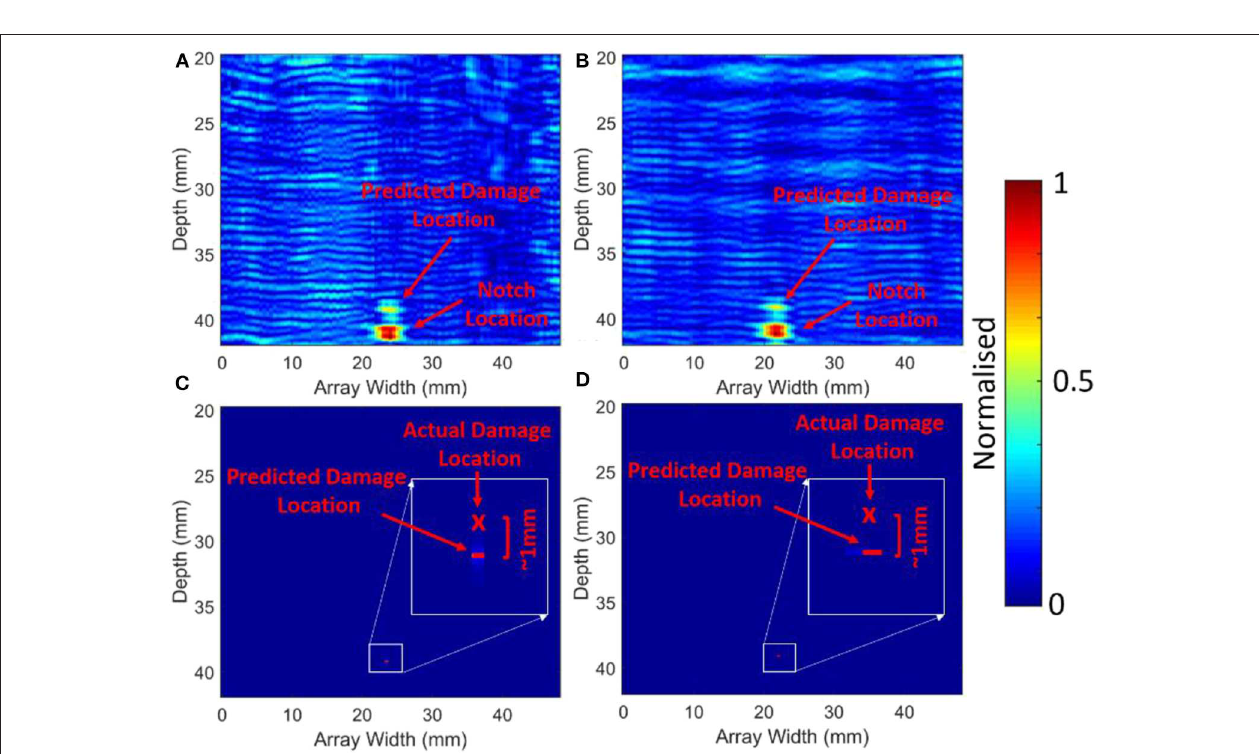
FIGURE 10 | SFC sample comparison of dual frequency (f 1 & f 2 = 4.8 & 5.3 MHz) and tri frequency modulation (f 1 & f 2 & f 3 = 4.8 & 5 & 5.2 MHz): (A) dual frequency M R 2 , (B) tri frequency M R 3 ; (C) dual frequency β S + D ; (D) tri frequency β TRI .